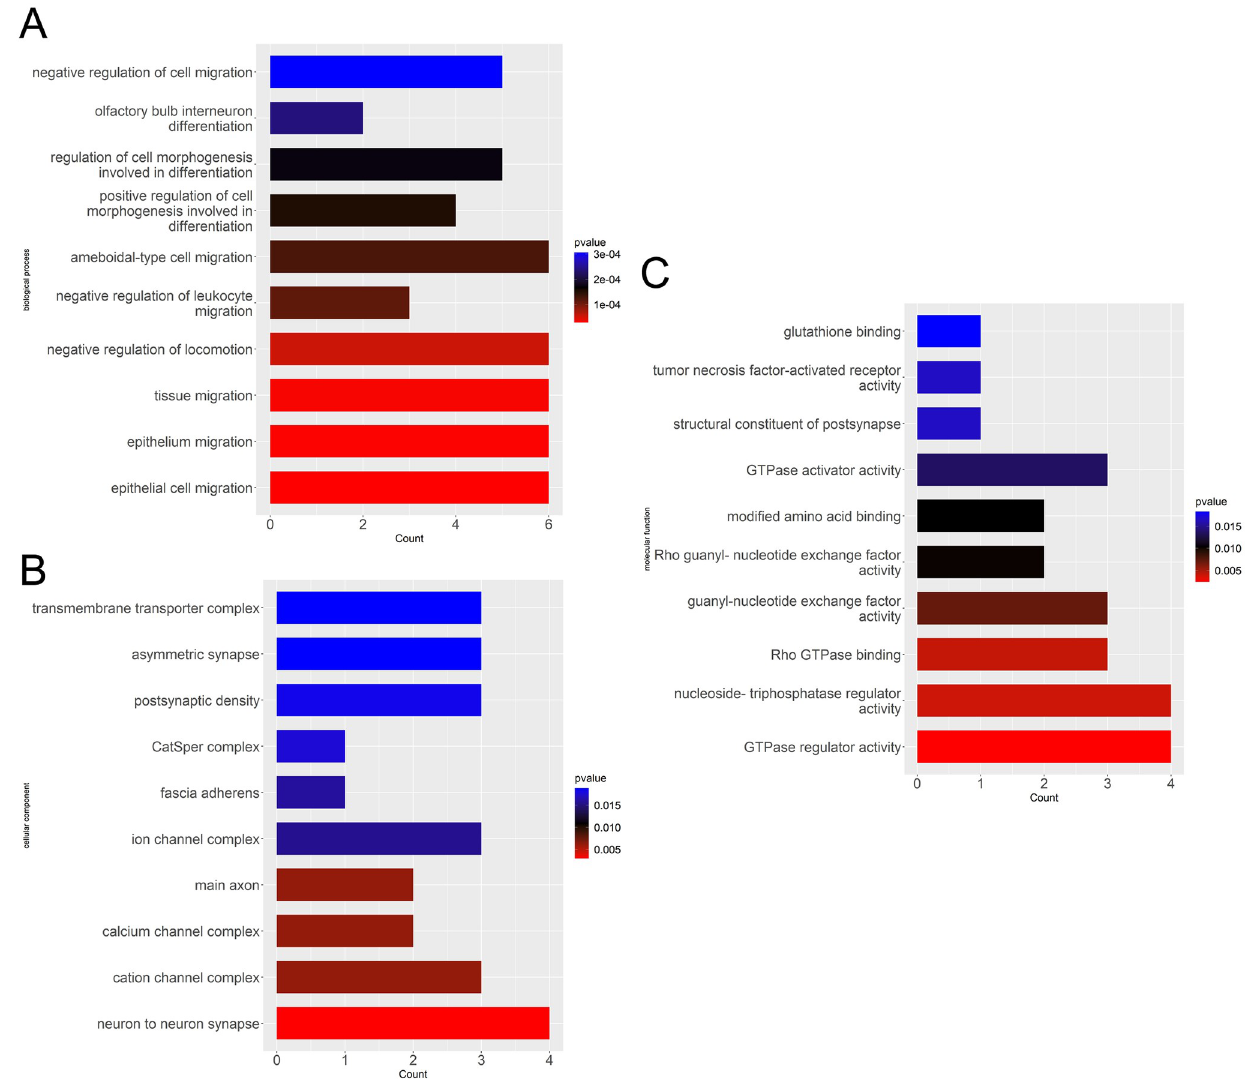
Fig 3. GO enrichment analyses of top 500 SNPs mapped genes. Top 500 SNPs mapped genes are classified into three functional categories, including biological process (A), cellular component (B) and molecular function (C). The ordinate axis represents different functional terms, and the abscissa axis represents the number of enriched genes. Different colors indicate different P values, Red: smaller P value, Blue: bigger P value.